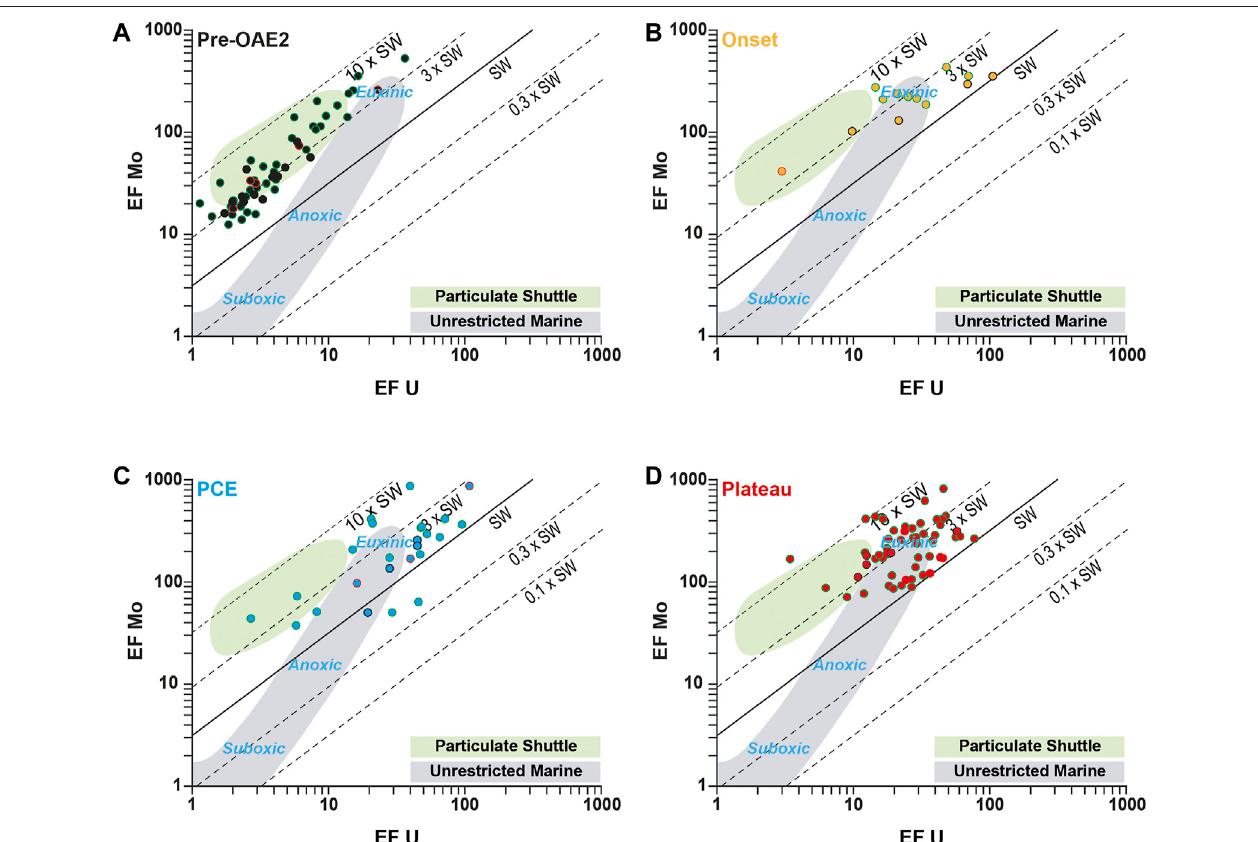
FIGURE 10| Cross-plot of EF U versus, EF Mo for the Pre-OAE-2 interval (A) , the onsetinterval (B) , the PCE interval (C) and the plateau interval (D) . Datafrom the studies of Westermann et al. (2014) and Dickson et al. (2016) are represented with circles with red and green outline respectively.